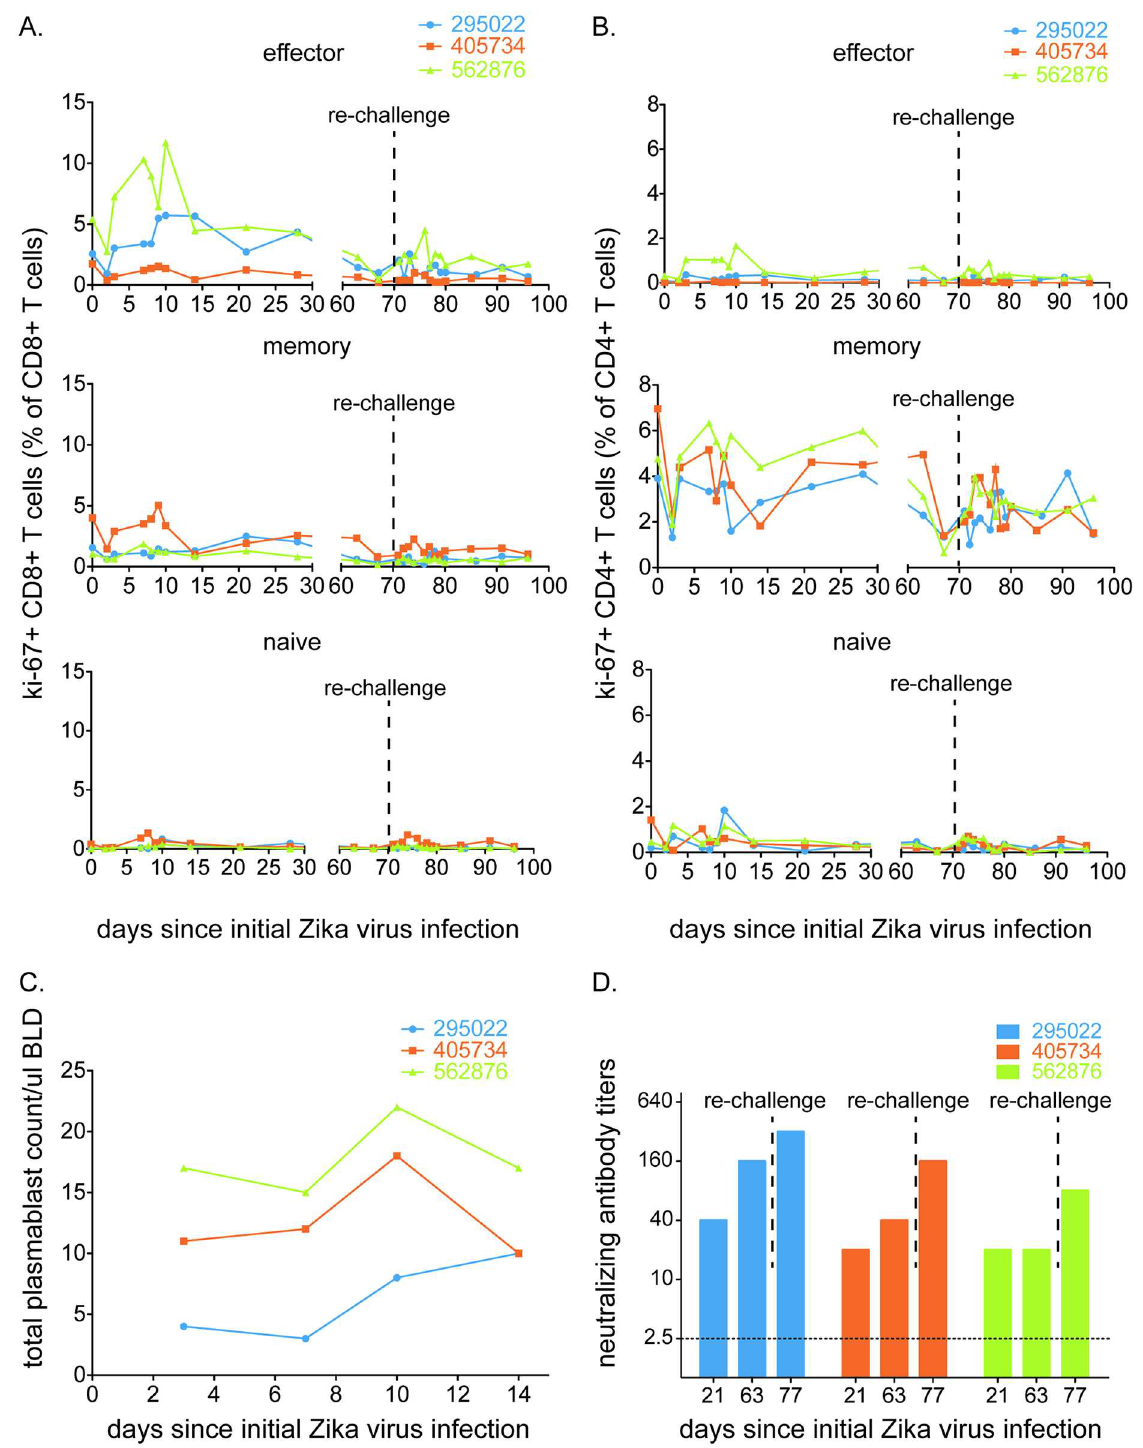
Fig 4. East African ZIKV MR766 infection elicits a robust, multifaceted immune response. Expansion of Ki-67+ (activated) A . CD8+ T cells (effector memory, central memory or naive) and B. CD4+ T cells (effector memory, central memory or naive) was measuredat days 0, 2, 3, and days 7 through 10, then on days 14, 21 and 28 post-infection. After a rest period, activated immune responses were measuredat days 63 and 67 post-infection. At 70 dpi, animalswere heterologously re-challenged with ZIKV-FP. Expansion of activated cells was measureddaily through 80 dpi, then at days 85 and 91 post-infection. Each